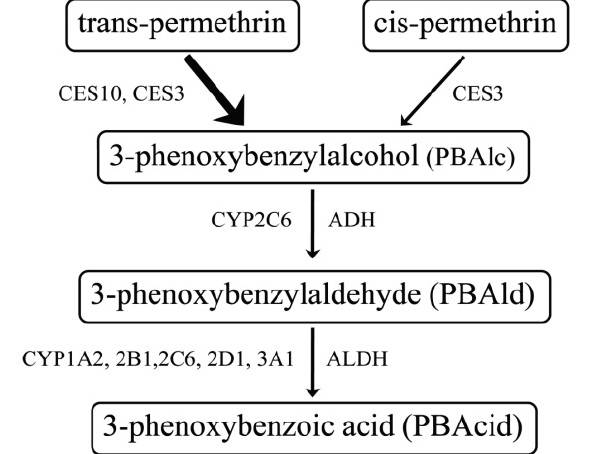
Figure 2. Scheme representing the metabolic pathway of permethrin in rat liver